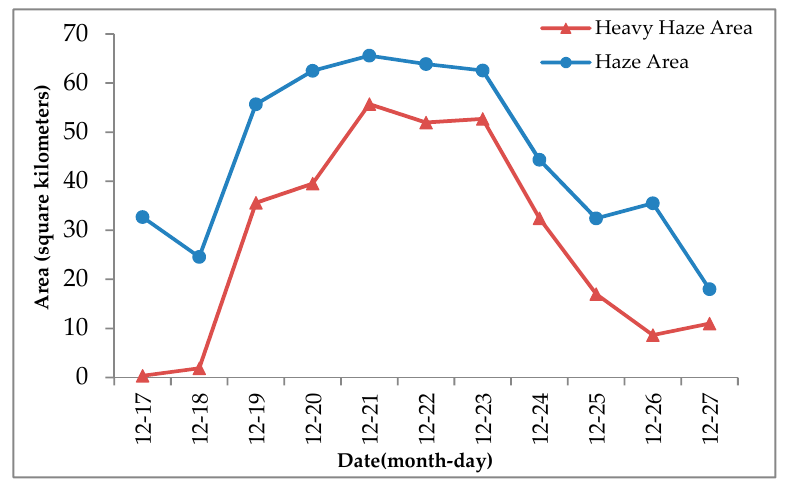
Figure 5. Daily variation of haze area from 17 December 2015 to 27 December 2015.